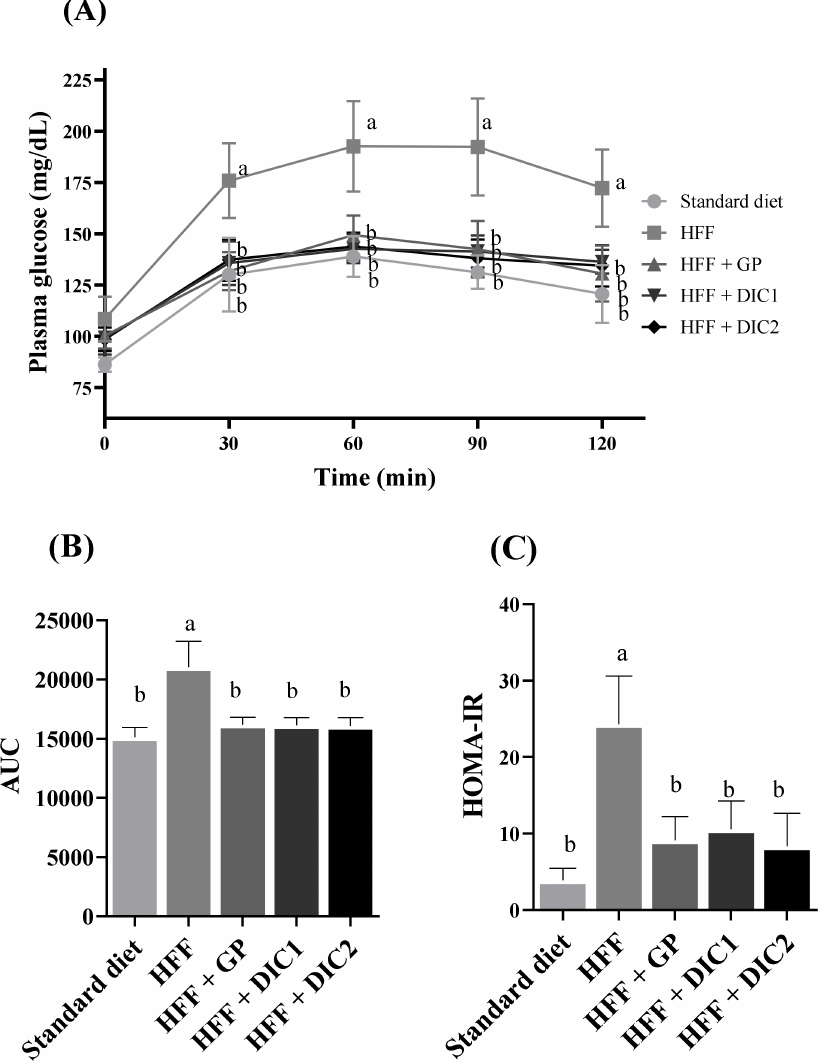
Figure 2. Effects of grape pomace subjected or not to DIC on glucose homeostasis in rats fed a HFF diet: ( A ) plasma glucose levels (mg/dL); ( B ) mean areas under the curves (AUCs) measured between 0 and 120 min after glucose loading; and ( C ) HOMA indexes. Data are reported as means ± SEs for eight animals per group. Different letters indicate significant differences between the